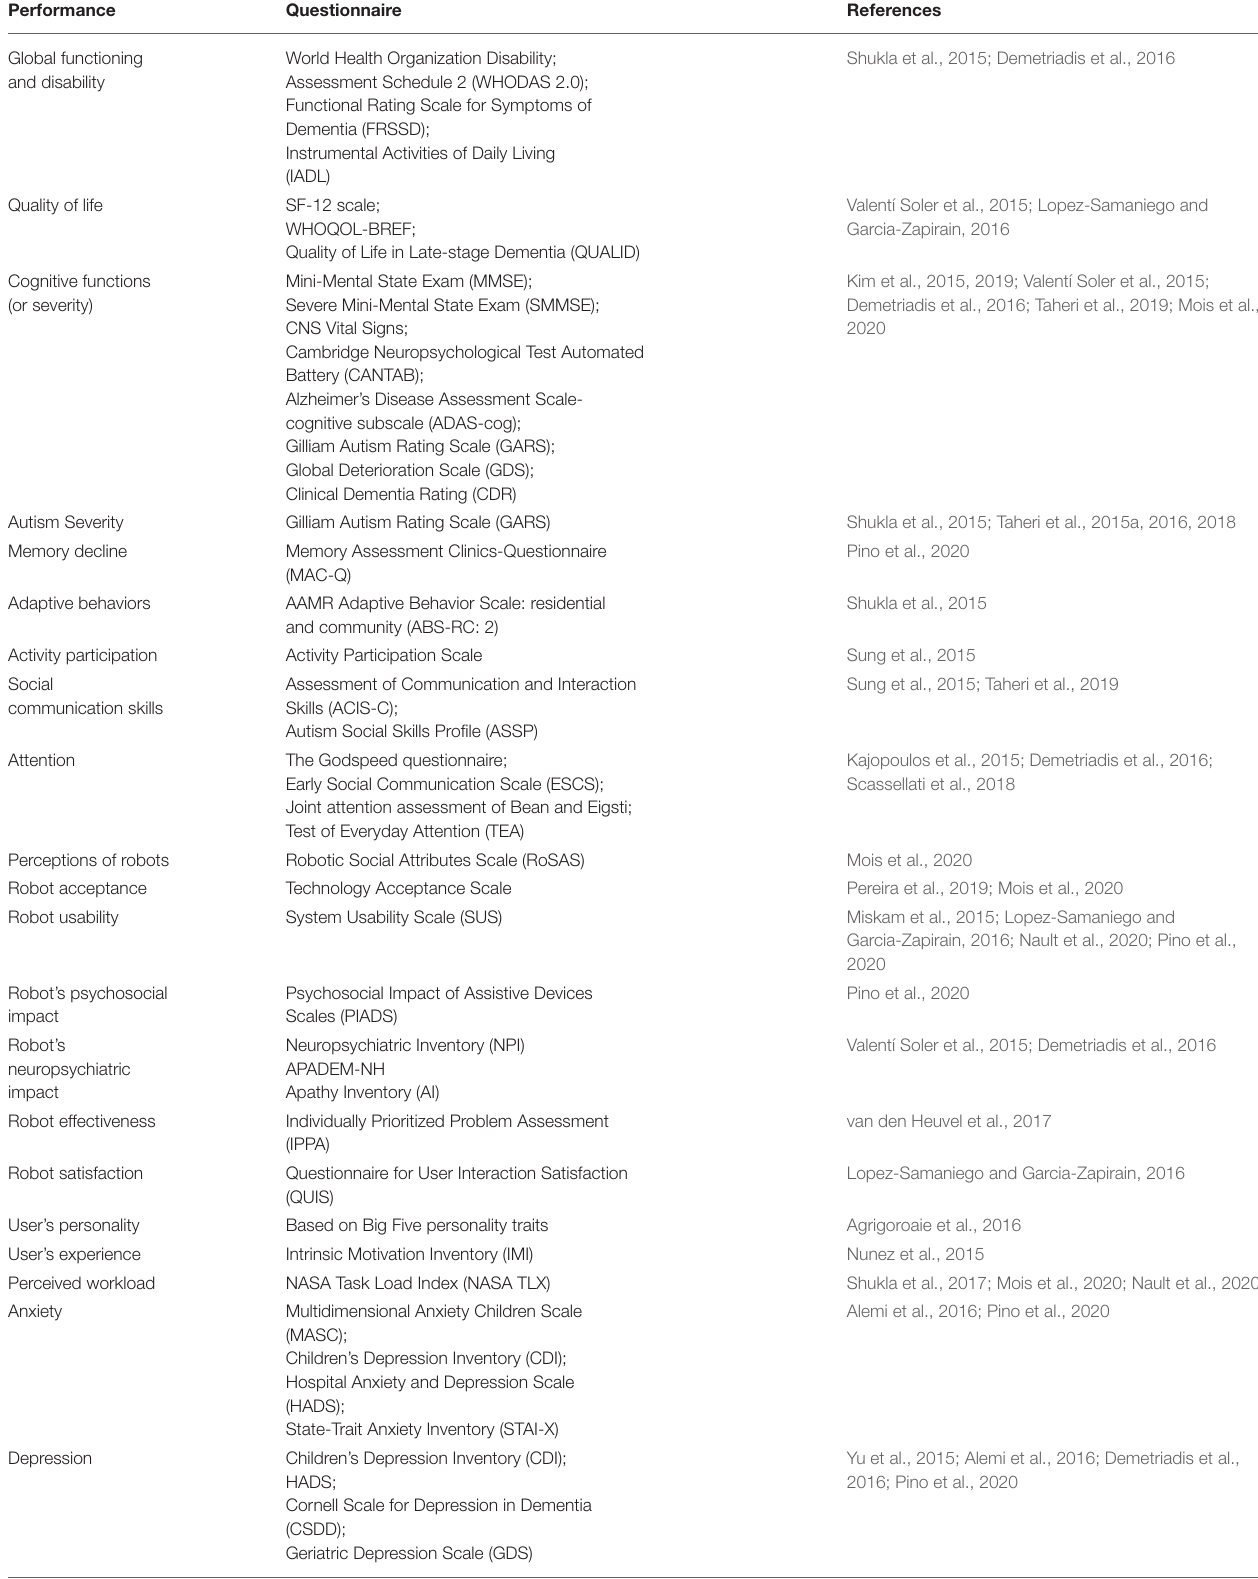
TABLE 3 | Questionnaires used to evaluate performance of robot-assisted cognitive